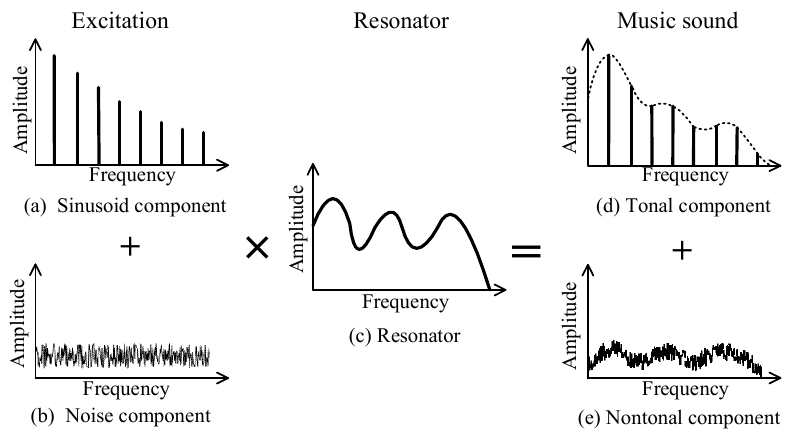
Figure 1. Improved source–filter model of the violin.